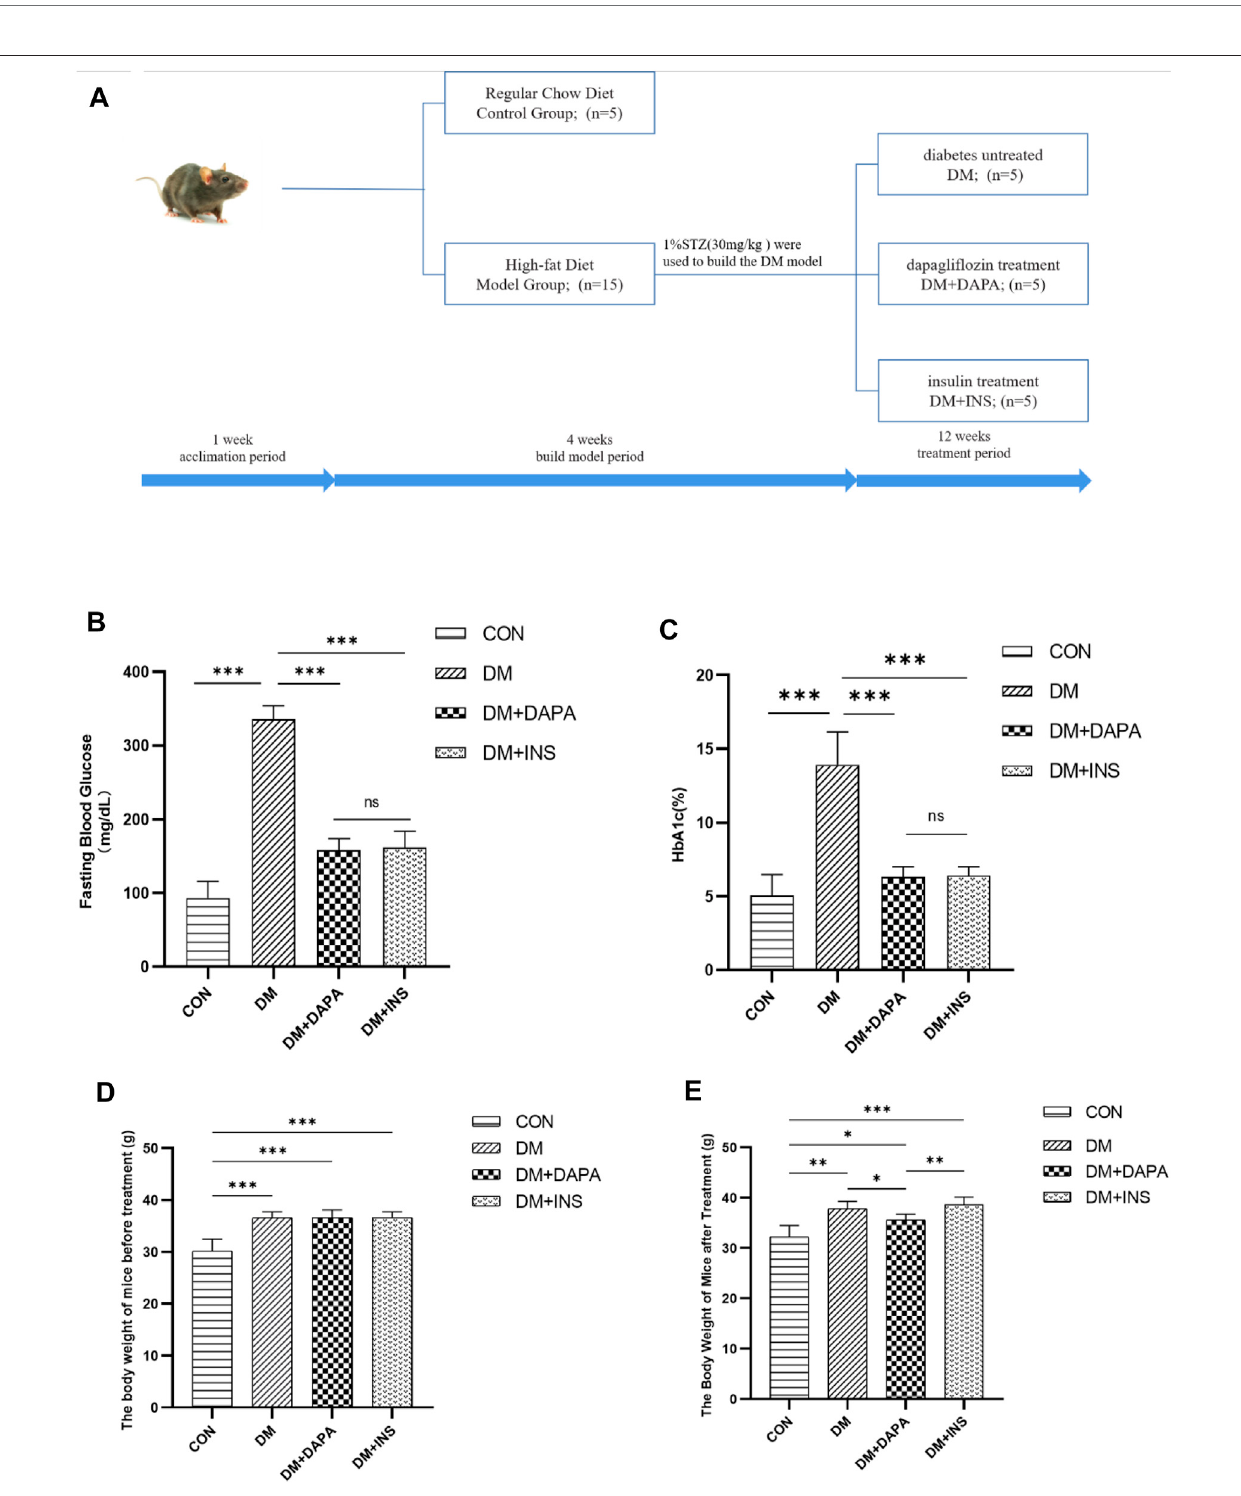
FIGURE1|(A) Schematic diagramofexperiment grouping. (B,C) Effect ofdapagli fl ozinonblood glucose and HbA1cindiabetic mice. (D,E) Effectofdapagli fl ozin on body weight of mice Data are presented as means ± SD. * p < 0.05, ** p < 0.01, *** p < 0.001.